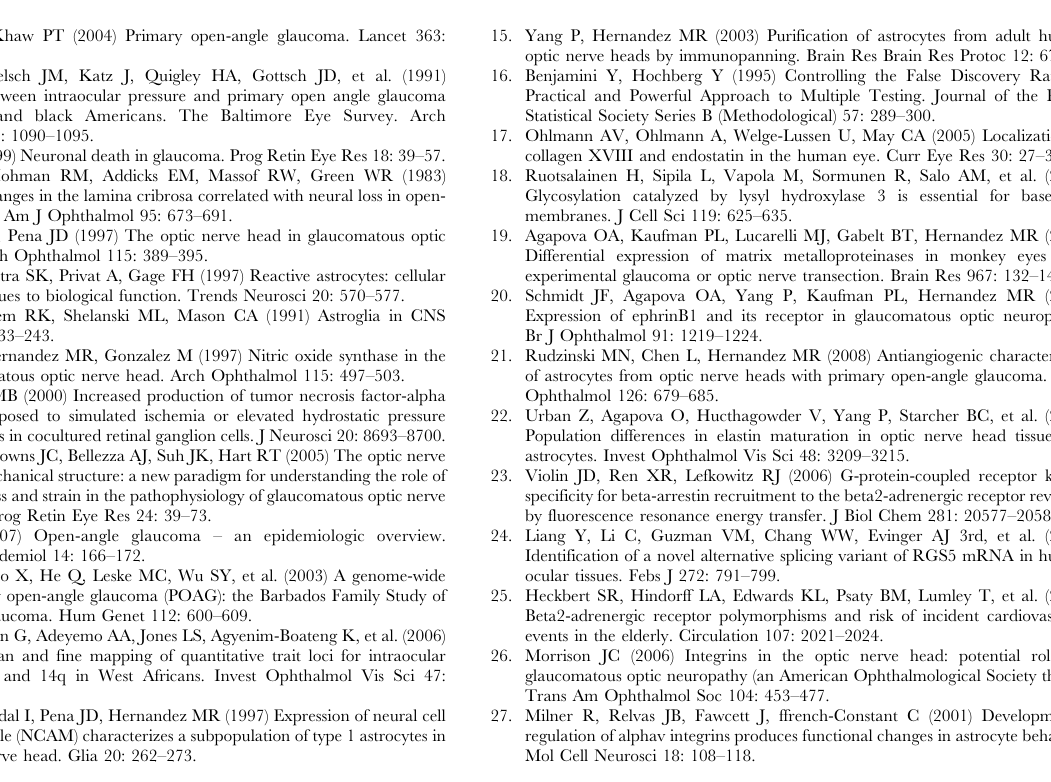
Table S6 Real-Time PCR validation of microarray expression analysis of normal Caucasian American and African American ONH astrocytes. Real-Time PCR validation of microarray